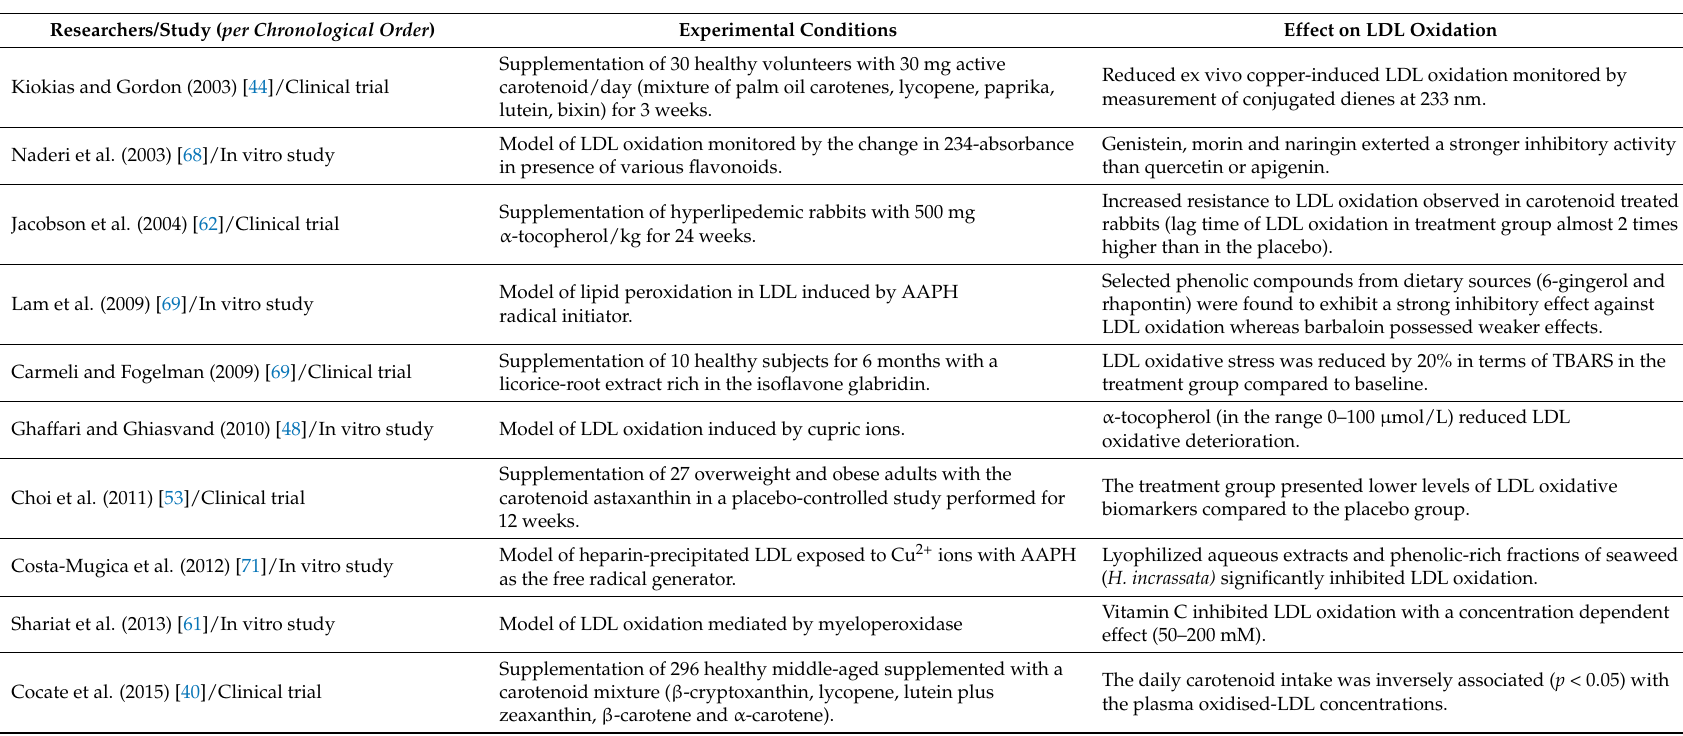
Table 1. Selection of studies on the effect of natural antioxidants against low-density lipoprotein (LDL) oxidative damage (conducted during the last 15